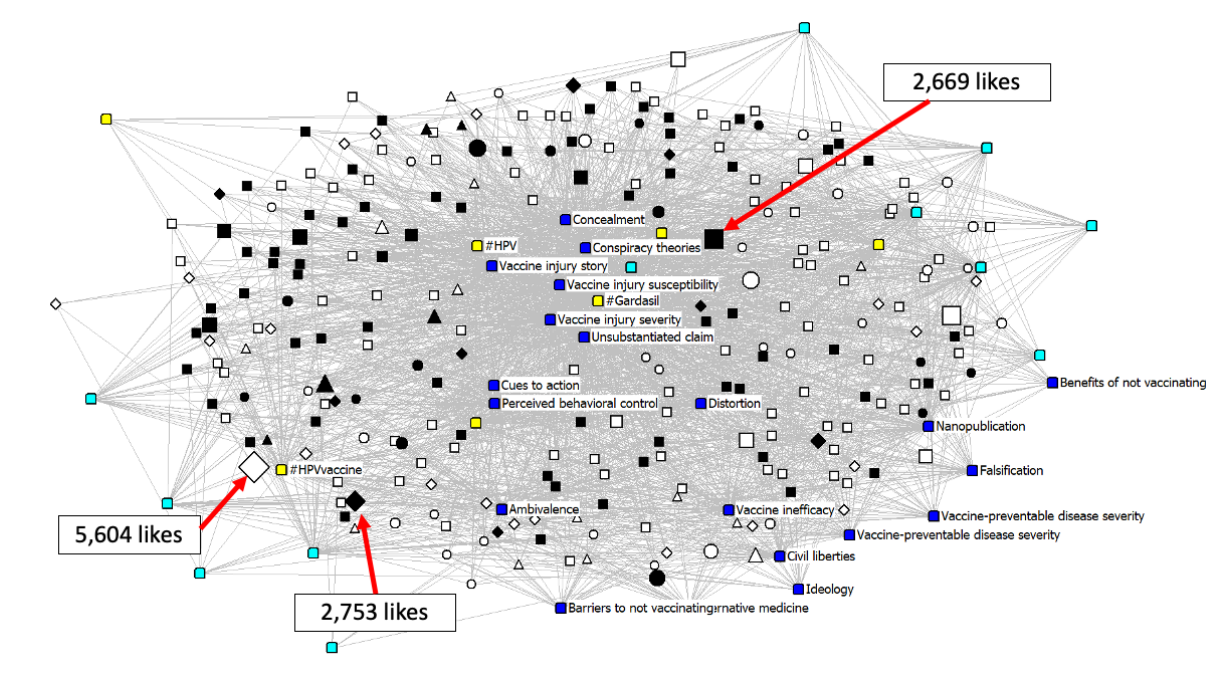
Figure 2. Antivaccine network visualization (n=256 posts). Variables colored by type of characteristic. Sized by likes (mean=220.9; median=27; maximum=5604). Top three posts with the most likes are indicated. Includes image, type of misinformation, and social media characteristics. Symbol shapes represent post source. Color represents node type. Yellow = social media features. Light blue = image characteristics. Dark blue = type of misinformation. Black = personal narrative. White = information/resource. Circle = general group. Square = general individual. Triangle = health group. Diamond = health